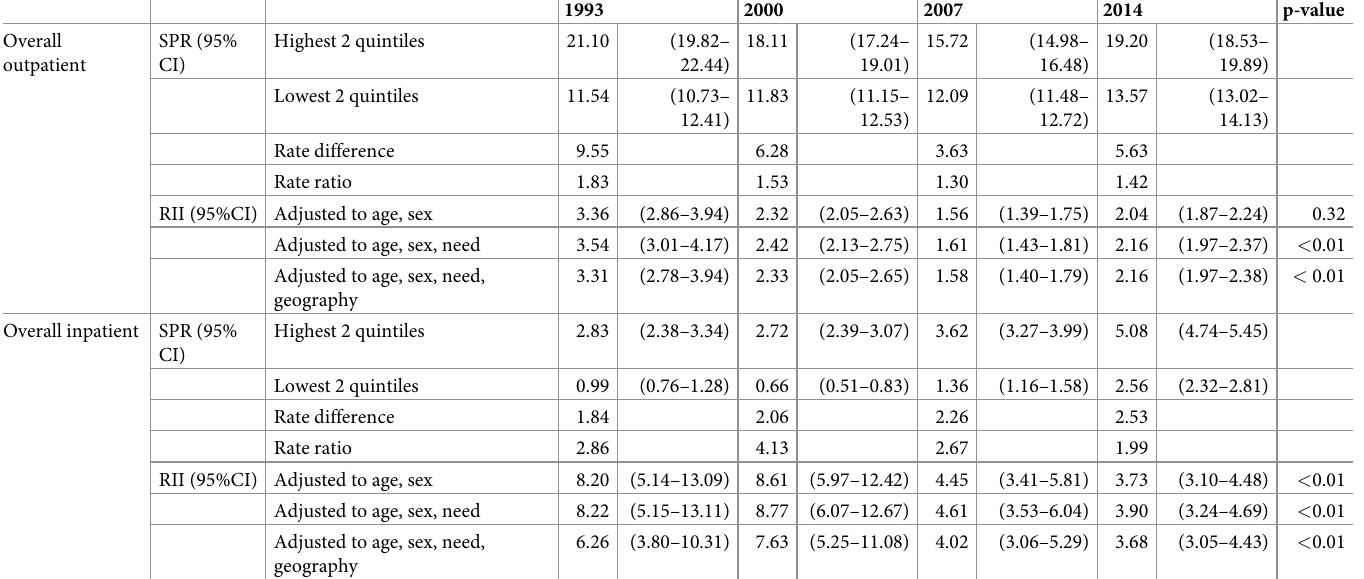
Table 4. Trends in absolute and relative income-related inequalities in overall utilisation,